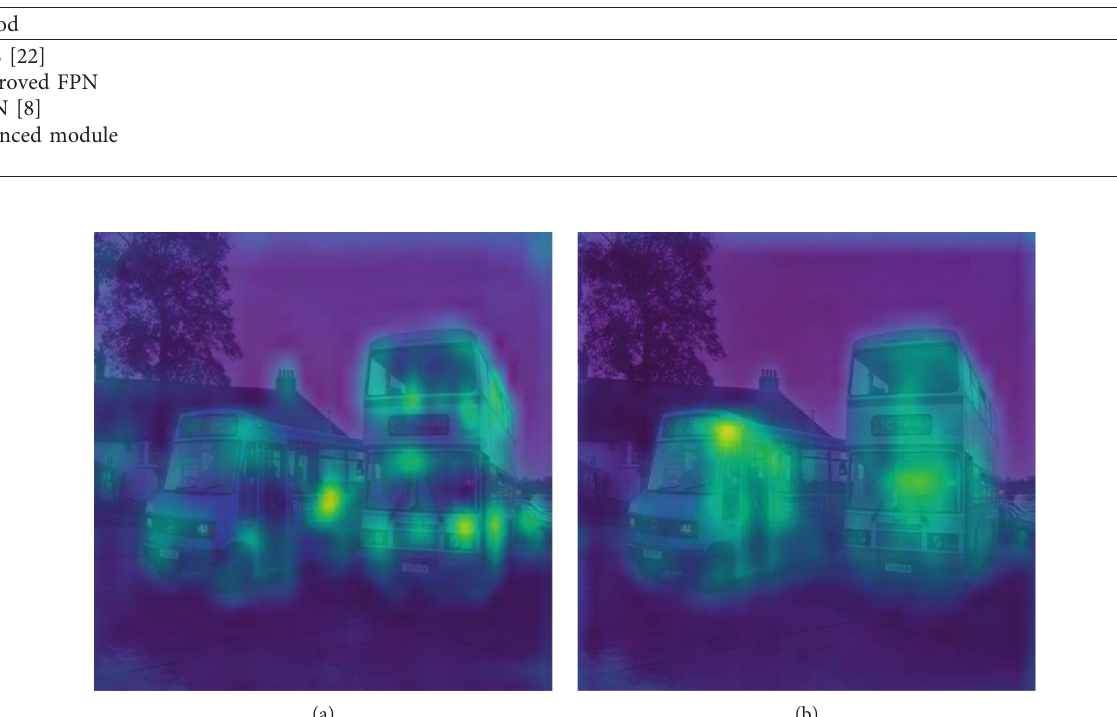
Figure 7: Ablation experiment example. (a) Figure without DCN, where its network attention is relatively distracted, and the sampling area cannot cover the overall target. (b) After adding DCN, the effect figure shows that the DCN sampling area is more comprehensive and can learn more features.